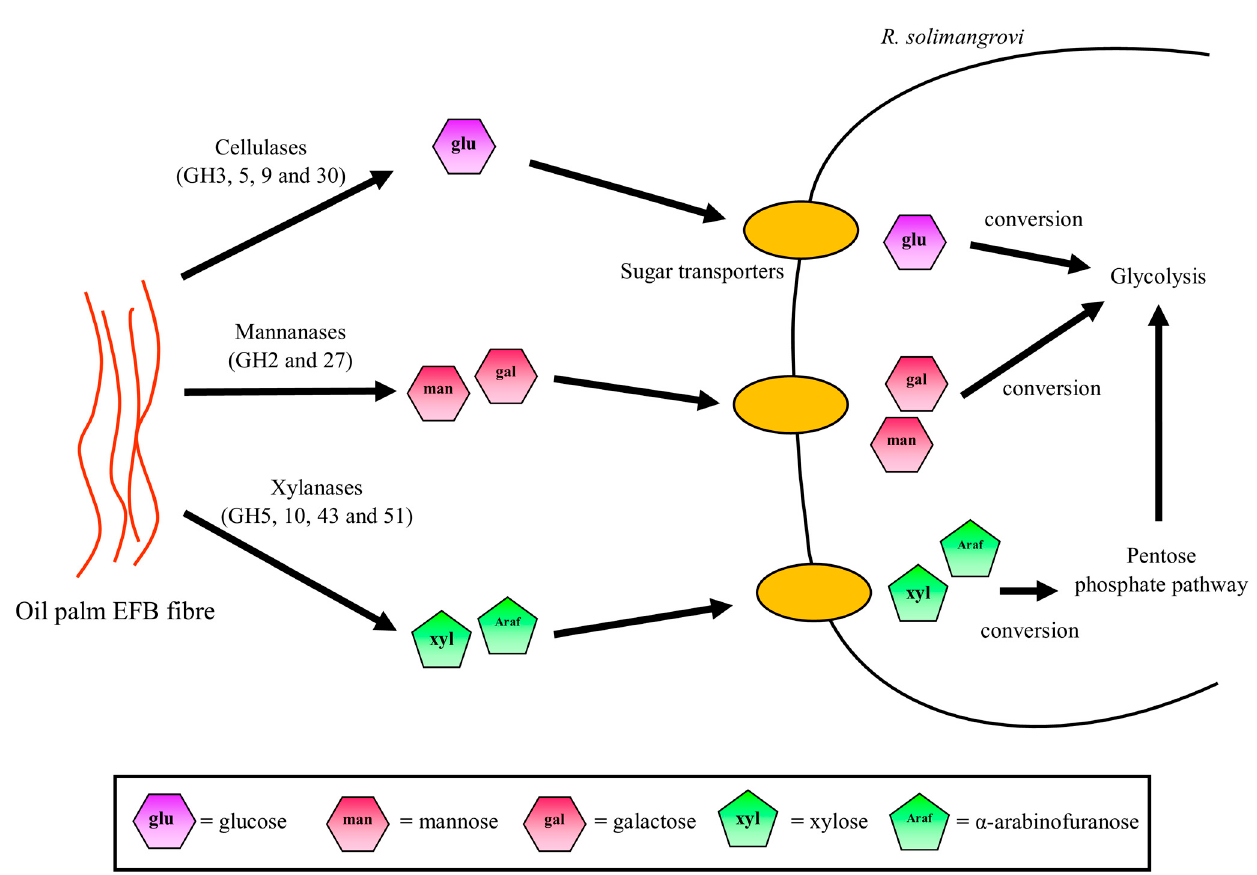
Figure 4. Sugar monomers transportation and metabolic pathways utilized by R. solimangrovi .